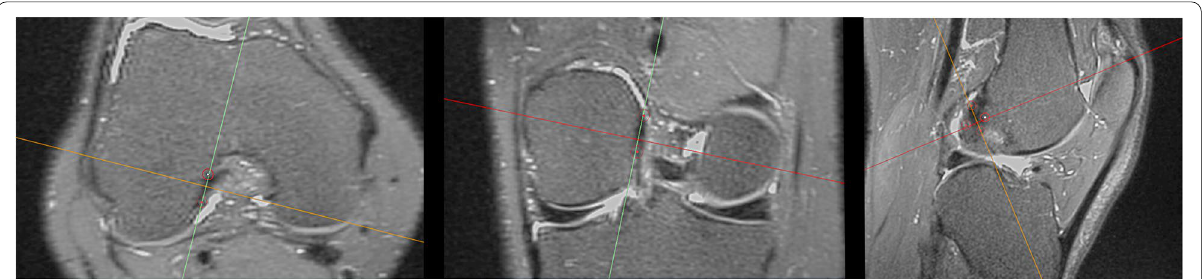
Fig. 1 Identification femoral ACL footprint in Materialise